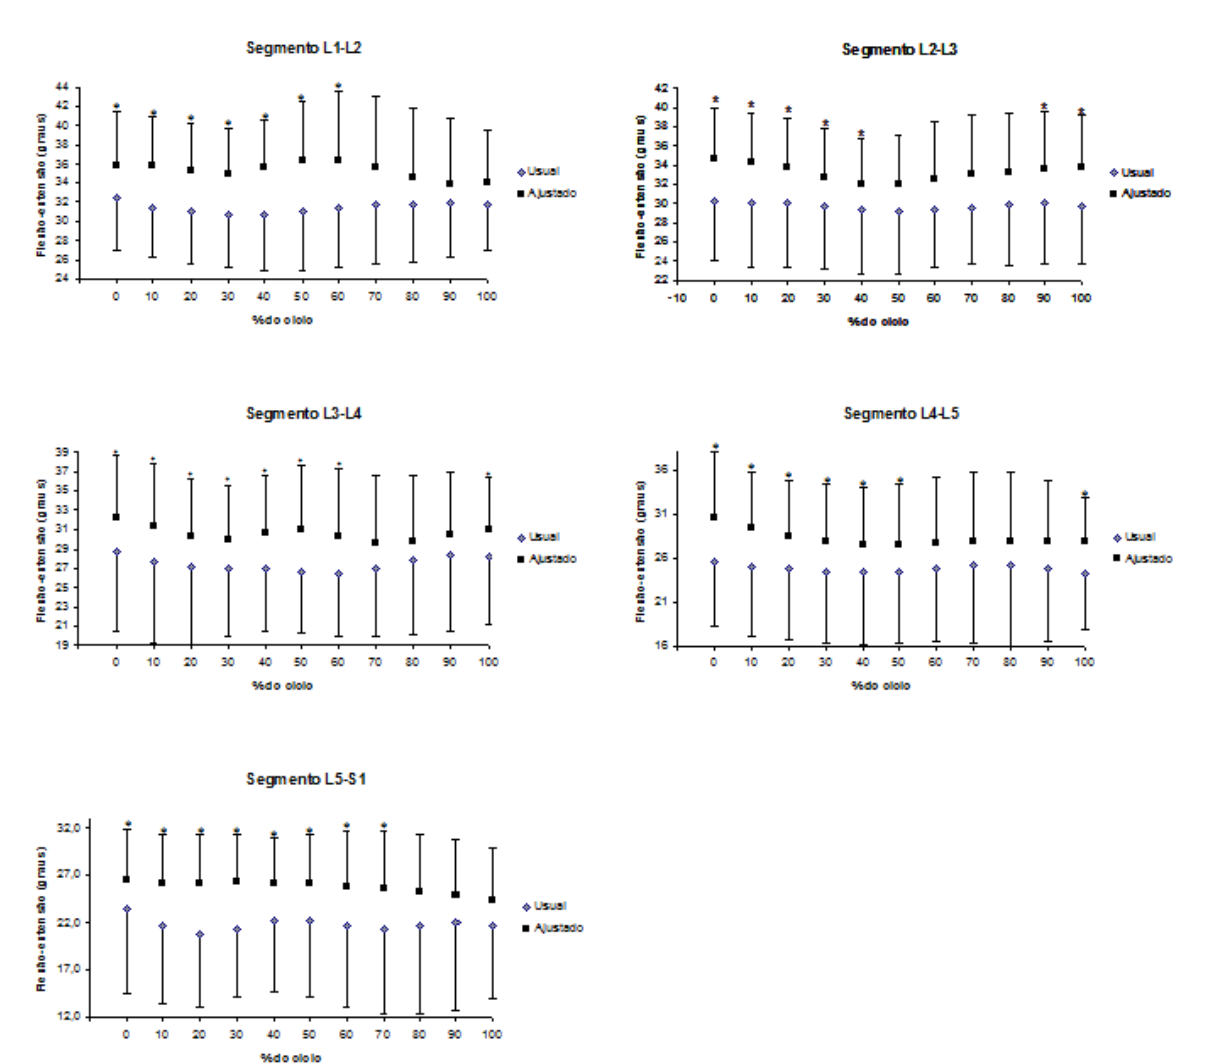
Figura 3. Comparação dos resultados de flexão-extensão da coluna lombar nas duas posições adotadas. * p<0,05 representa valor estatisticamente significativo ( Bonferroni ) entre as situações de selim ajustado e